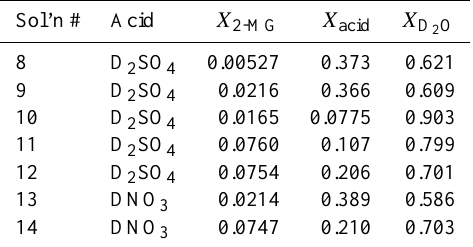
Table 1. Initial mole fraction composition for perchloric acid con- Table 2. Initial mole fraction composition for sulfuric and ni- trolled composition experiments. Total solution mass ranged from tric acid controlled composition experiments. Total solution mass 1.6–2.1 g. Sum of listed mole fractions not equal to unity due to ranged from 1.4–2.0 g. Sum of listed mole fractions not equal to = 0 . 004–0.02) and DSS ( X = presence of NaClO 4 ( X NaClO unity due to presence of NaClO 4 ( X NaClO DSS 4